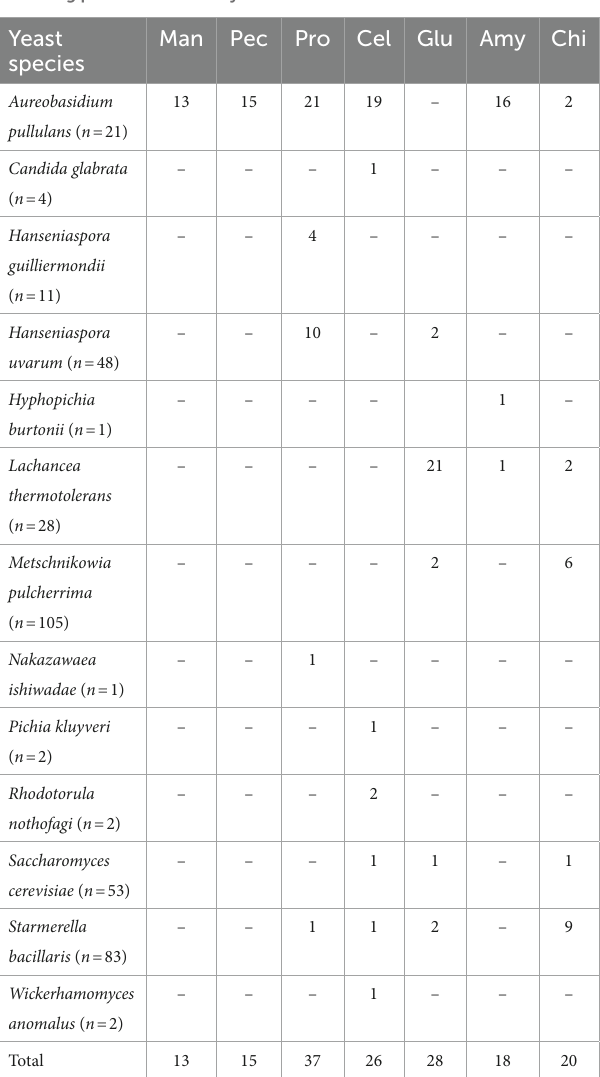
TABLE 1 Yeast species comprising strains with positive results in the screening performed for enzymatic